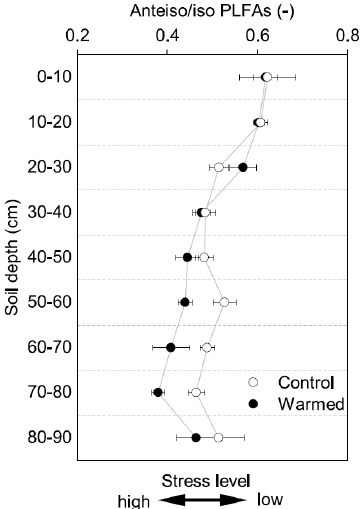
Figure 3. The ratio of anteiso to iso PLFAs in control and warmed plots after 4.5 years of + 4 ◦ C soil warming (mean ± SE; n = 3). This ratio has been interpreted as being an indicator of stress on Gram + bacteria, with lower values indicating a higher stress